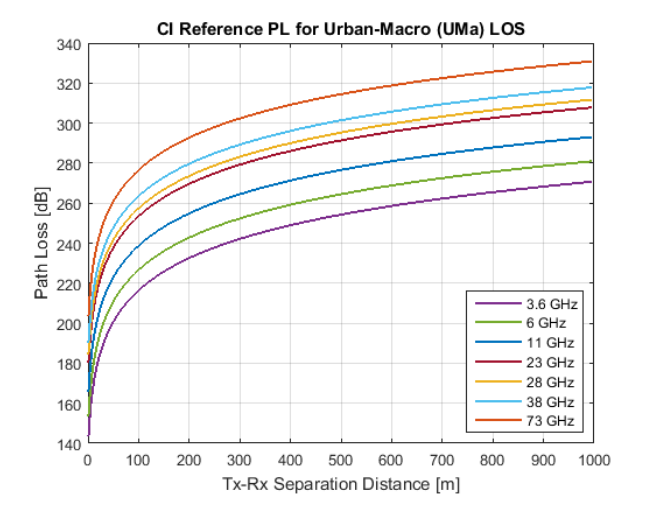
Fig 25. CI UMa LOS (1000